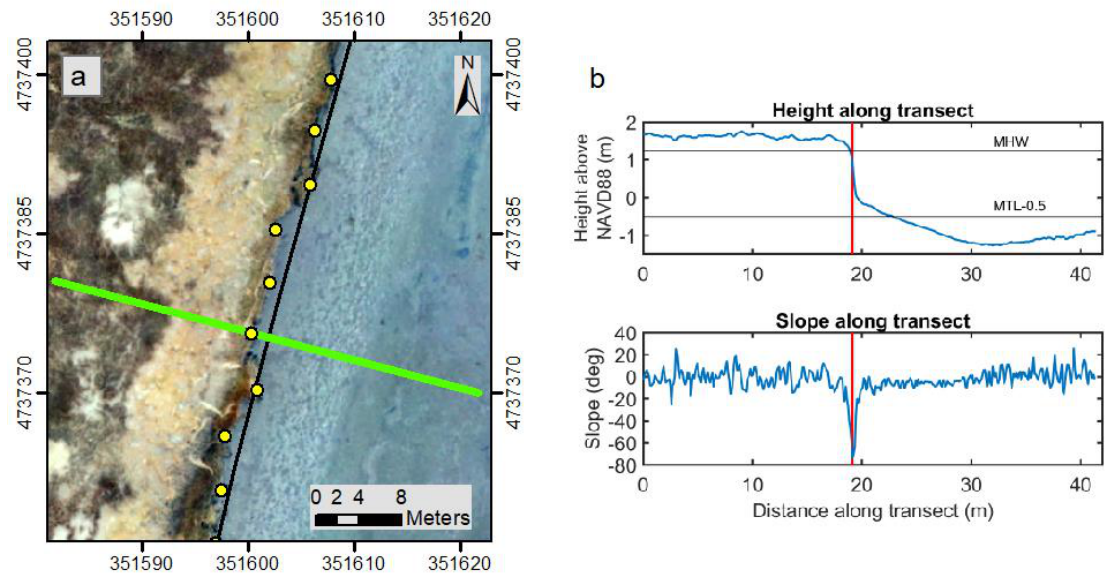
Figure 4. ( a ) UAS imagery from Plum Island, MA. The black line is the smoothed mean tide level